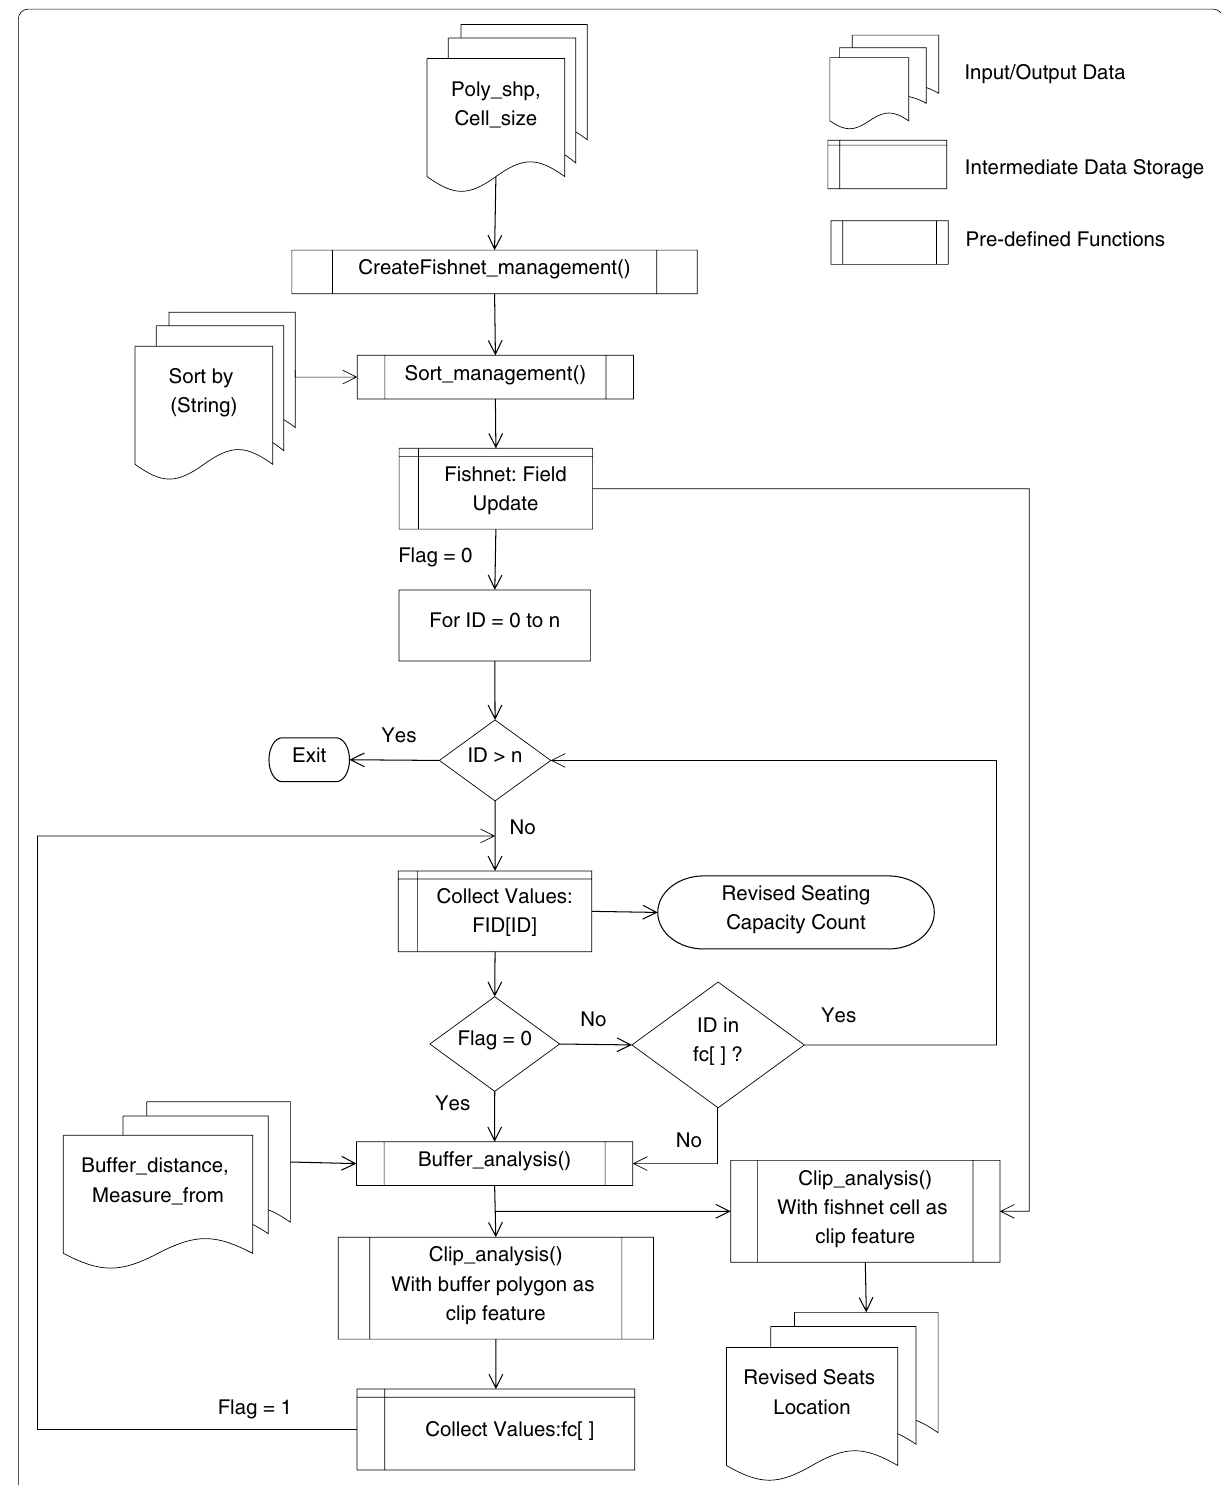
Fig. 3 The flowchart of flexible model seating capacity